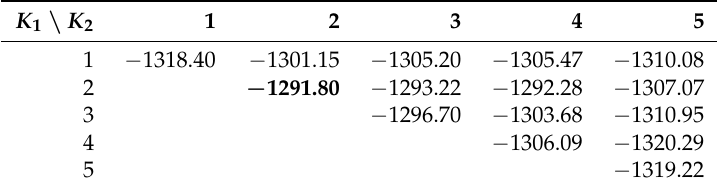
Figure 7. Comparison of the true and of the estimated clustering subspaces on the illustrative example, points are marked according to the estimated clusters. Table 1. Value of the BIC criterion according to K 1 and K 2 , for the choice of the number of clusters on the illustrative example, best value in